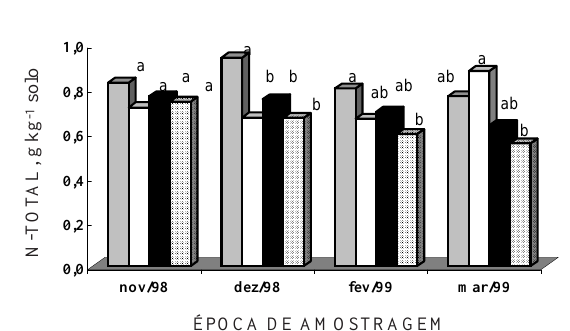
Figura 1. Atividade de proteases em Latossolo Vermelho distrófico cultivado com laranjeira em diferentes épocas, locais e profundidades de amostragem (PC = linha de projeção da copa, EL = entrelinhas). Letras comparam atividades dentro de cada época de amostragem a 5 % pelo teste de Tukey.